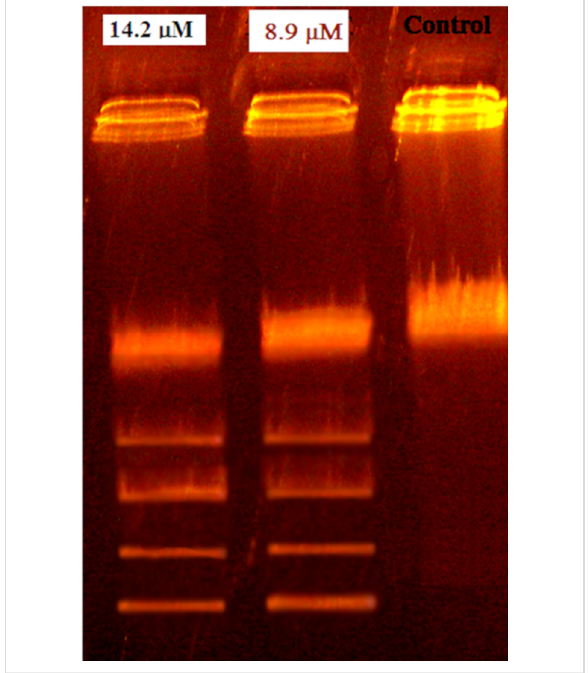
Figure 7: DNA Ladder formation in a gel electrophoresis study of 11b at different concentrations (at 8.9, and 14.2 µM, respectively) on HeLa after 24 h